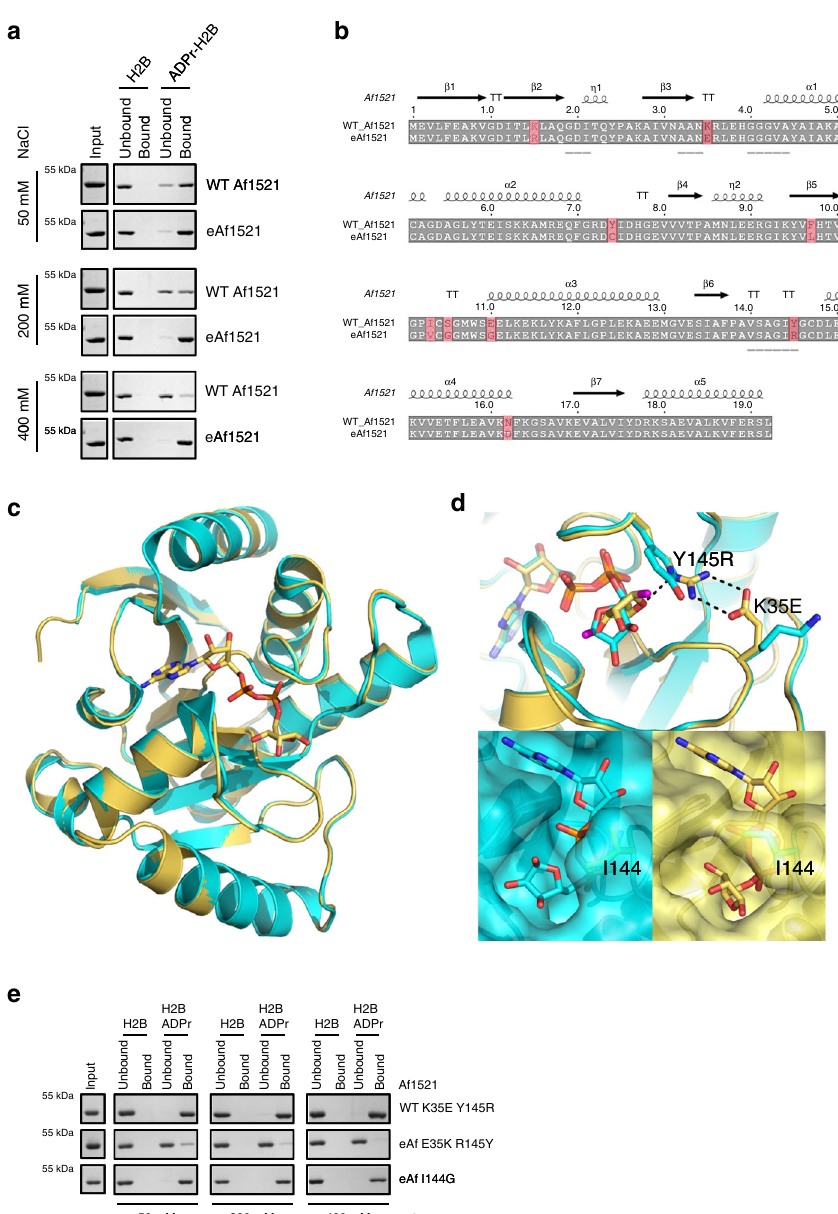
Fig. 1 Characterization of engineered Af1521 macro domain. a Pull-down experiment using unmodi fi ed and ADP-ribosylated H2B peptides (biotinylated and bound to streptavidin Sepharose beads) of WT Af1521 and eAf1521 under conditions with increasing salt concentrations. Input lanes are the same for all measured conditions. The proteins were detected with SDS – PAGE followed by Coomassie staining. The experiment was repeated independently ( n = 3) with similar results. b Sequence alignment of WT Af1521 and eAf1521. Point mutations in eAf1521 are highlighted. The binding region is underlined. c Structural comparison of the eAf1521 (mustard) and WT Af1521 (turquoise; PDB ID: 2BFQ). d Upper panel: detailed representation of the proximal ribose of the ADPr with the point mutations Y145R and K35E in its vicinity. The C-1 ′ -linked oxygen is shown in purple. Lower panel left: surface rendering of the WT Af1521 ADPr-binding site. The I144 side chain is highlighted. Lower panel right: corresponding view for the eAf1521 macro domain, with the I144 side chain rotated to entrap the diphosphate moiety. e Pull-down experiment using unmodi fi ed and ADP-ribosylated H2B peptides (biotinylated and bound to streptavidin Sepharose beads) of WT Af1521-K35E-Y145R, eAf1521-E35K-R145Y, and eAf1521-I144G under increasing salt concentration. Input lanes are the same for all measured conditions. The proteins were analyzed by SDS – PAGE followed by Coomassie staining. The experiment was repeated independently ( n = 2) with similar results. Source data are provided as a Source data fi